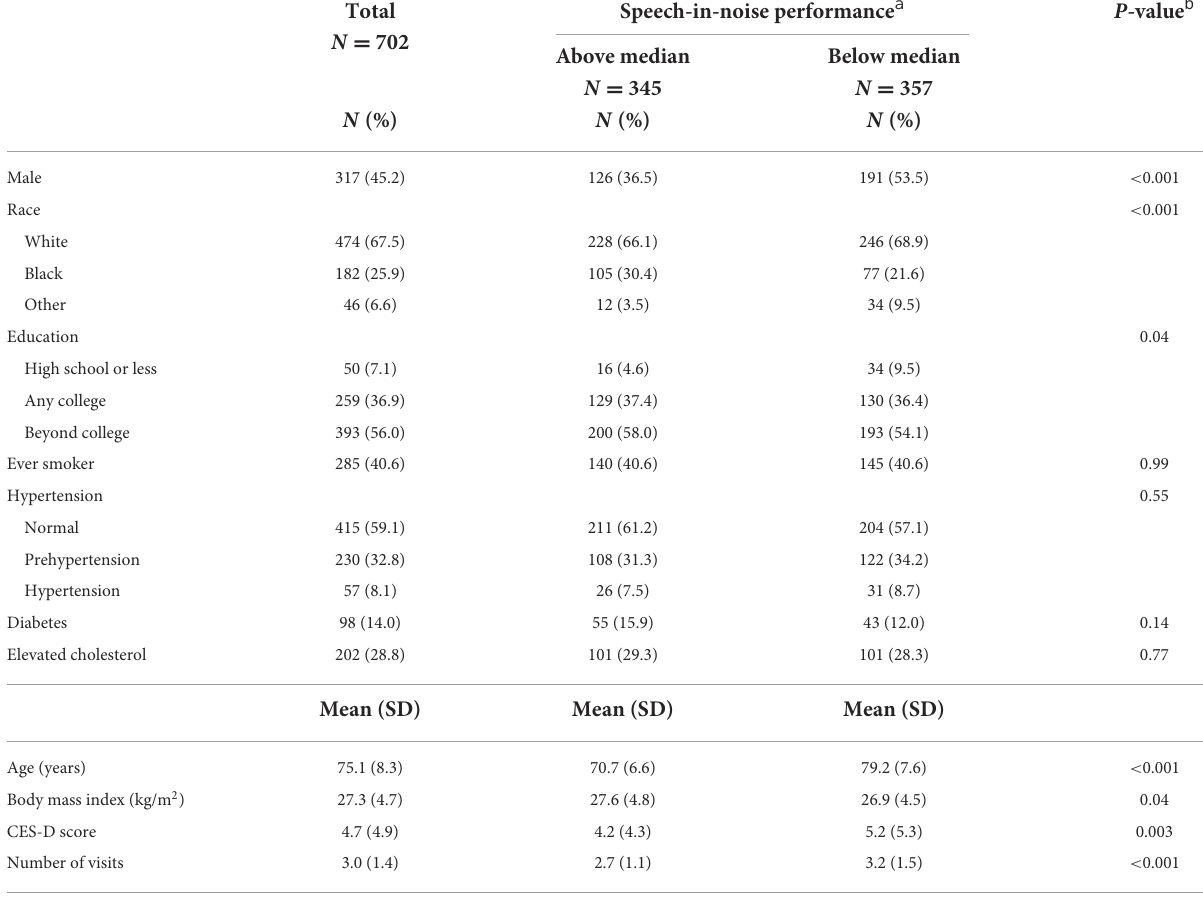
TABLE 3 Baseline characteristics of participants by speech-in-noise performance in the Baltimore Longitudinal Study of Aging 2012–2019.